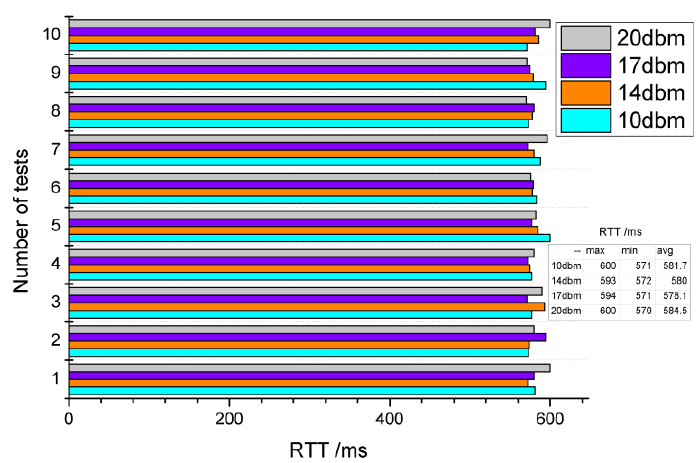
Figure 8. Relationship between round-trip time (RTT) and send power.